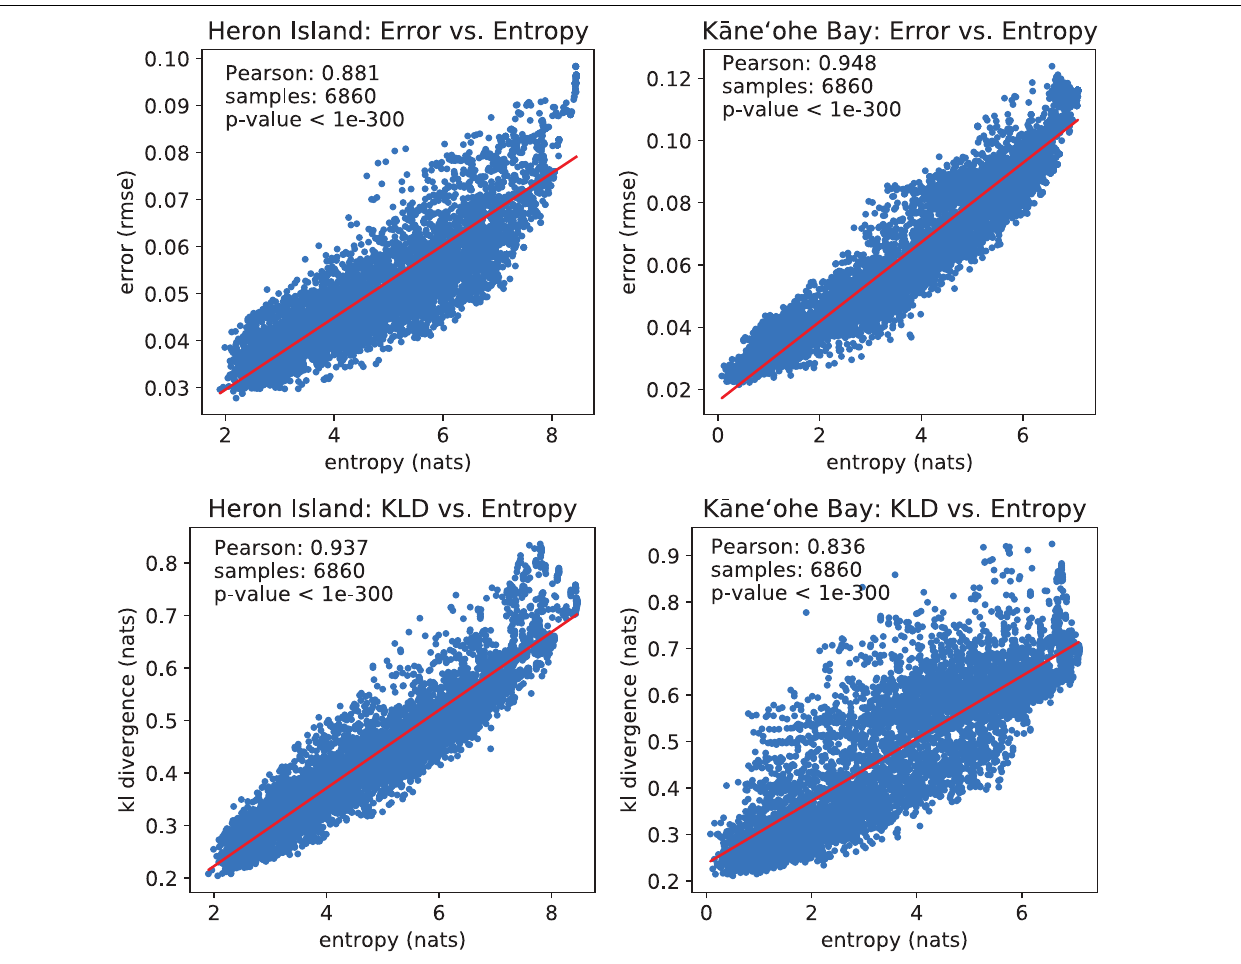
FIGURE 11 | Top row: Spectral reconstruction error (RMSE) vs. model uncertainty (entropy). Both variables are strongly correlated according to Pearson’s correlation coefficient. Bottom row: Unmixing accuracy (KLD) vs. model uncertainty (entropy). Both variables are strongly correlated according to Pearson’s correlation